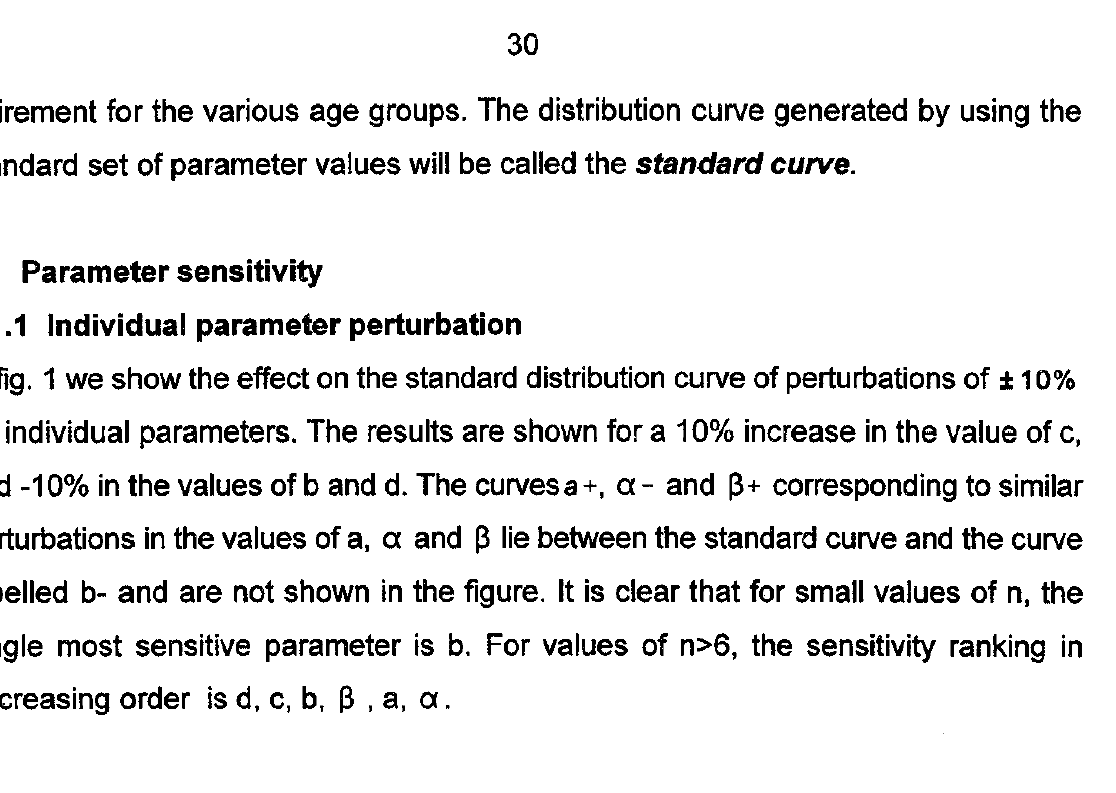
Figure 1: Sensitivity of distribution curve to individual